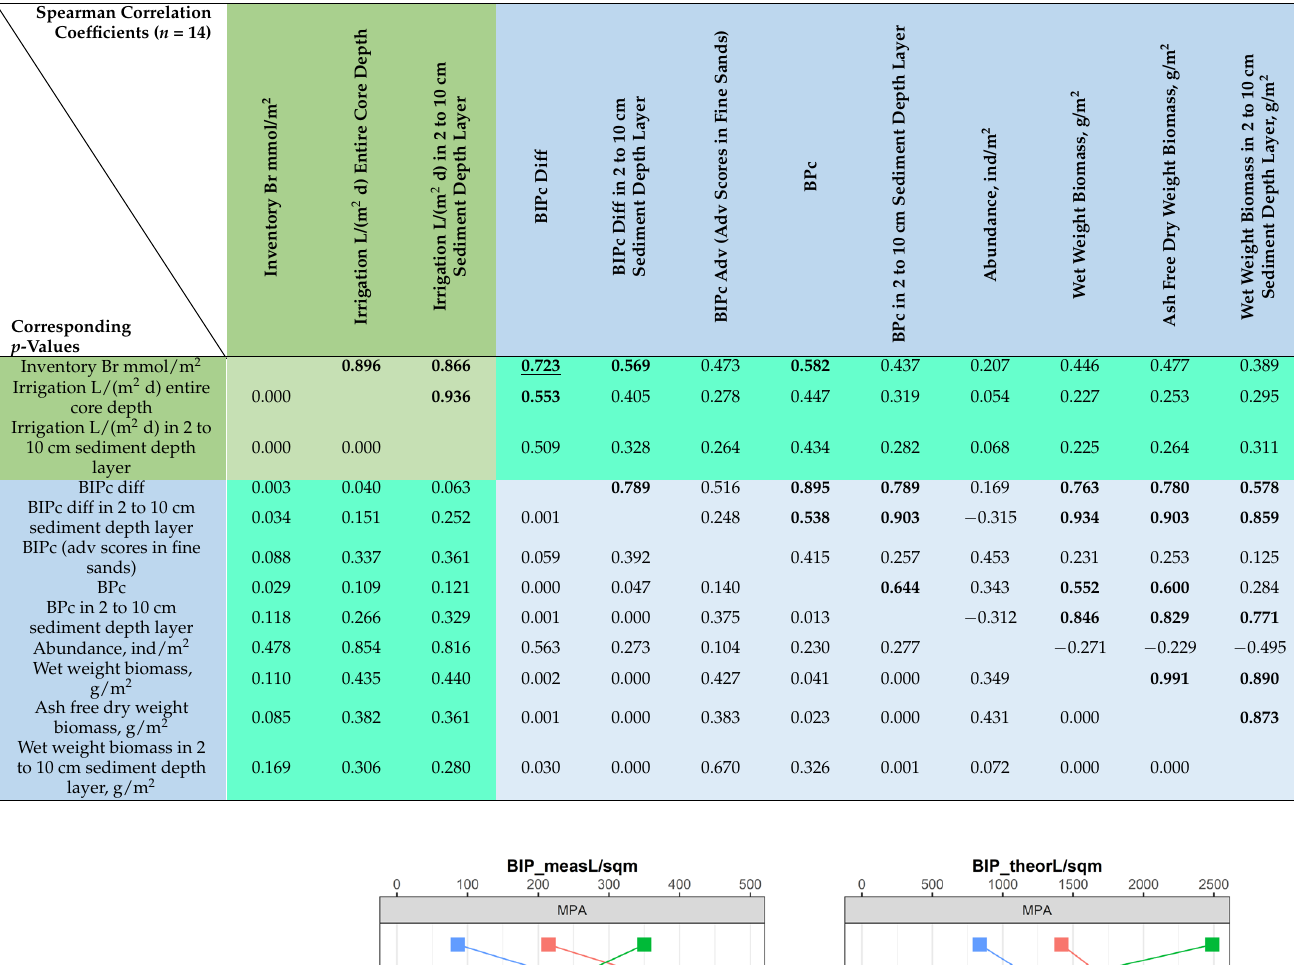
Table 3. Spearman correlation coefficients (above the diagonal) with significance levels ( p -value below the diagonal) calculated between bioirrigation intensity measured in 14 cores using bromide tracer (marked in green) and macrofauna parameters and functional indices BIPc and BPc (marked in blue). Significant correlation coefficients are shown in bold font. To calculate BIPc diff, the corresponding diffusion system scores are used for all cores, whereas for BIPc adv, advective scores are applied for fine sand sediment cores.